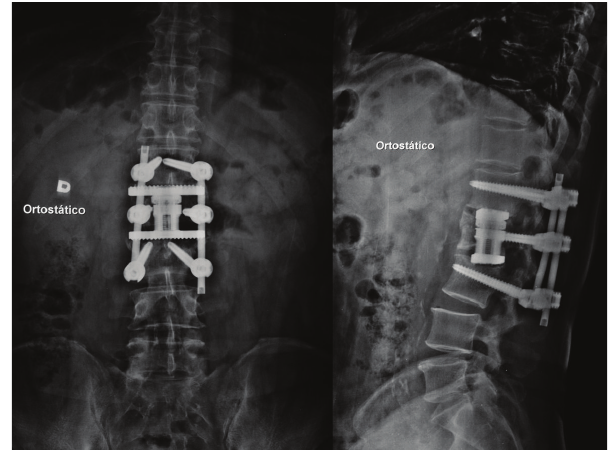
Figure 3: AP and lateral X-rays showing good coronal and sagittal alignments 12 months after